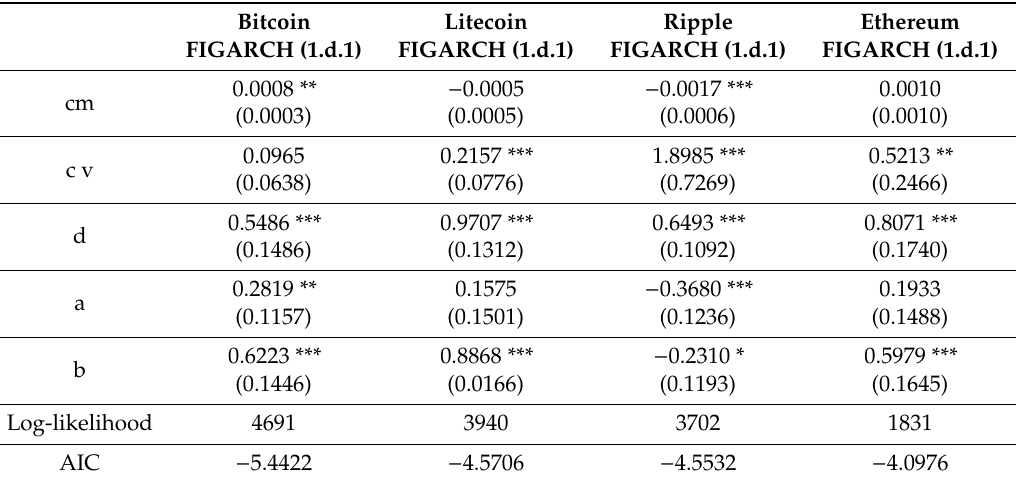
Table 5. FIGARCH model